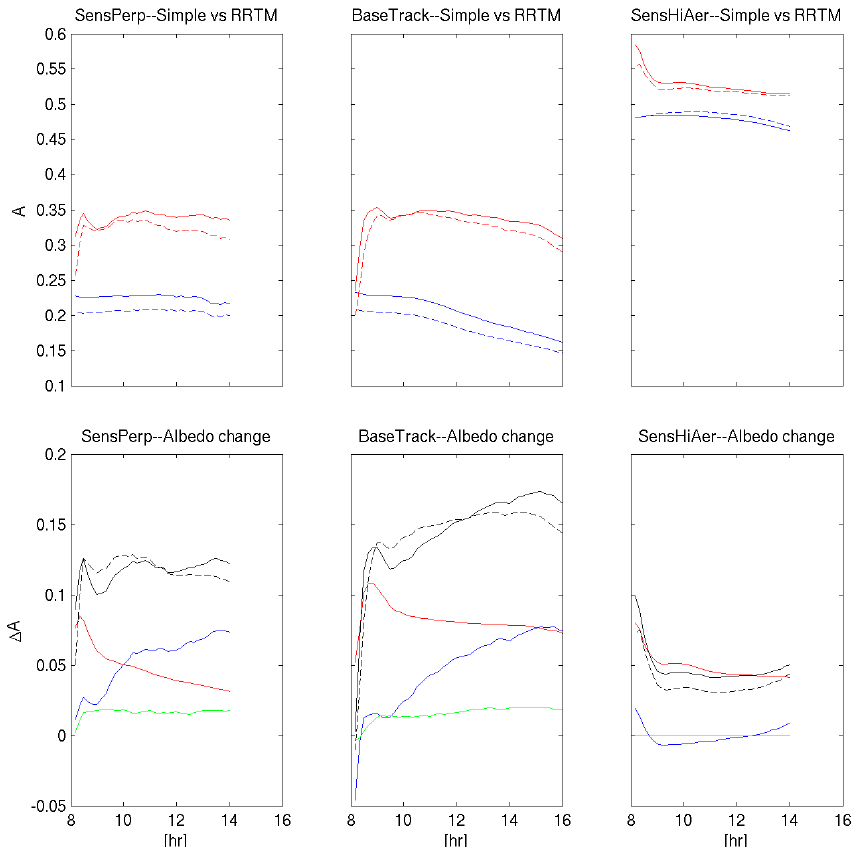
Figure 17. Top row: simple model (solid lines) and rapid radiative transfer model (RRTM; dashed lines) predicted A for the track (red lines) and background (blue lines) in runs SensPerp (first column), BaseTrack (second column), and SensHiAer (third column). Bottom row: Albedo change due to changes of N d (red lines), W cld (blue lines), and f c (green lines), as well as total predicted change (cid:49)A by the sum of terms (solid black lines) and derived from RRTM (dashed black lines). Runs are as in top